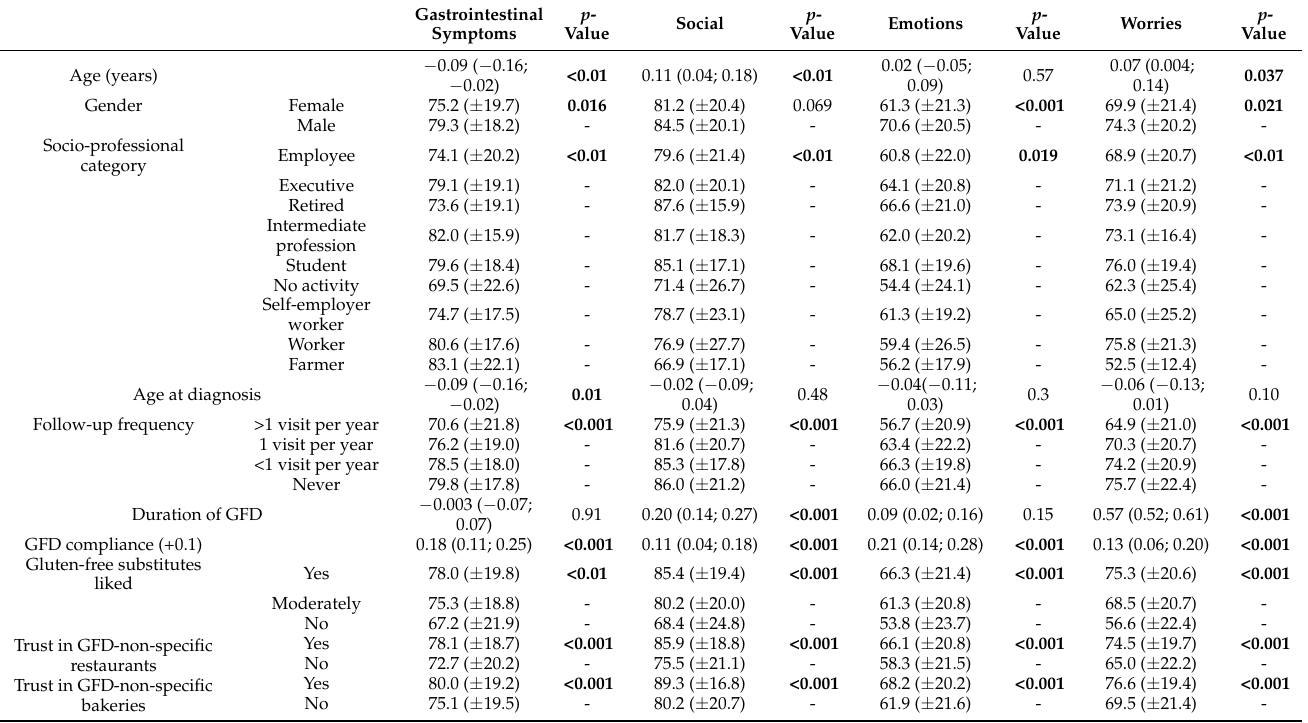
Significant correlations between subdomains of the F-CDQ score and patients or disease